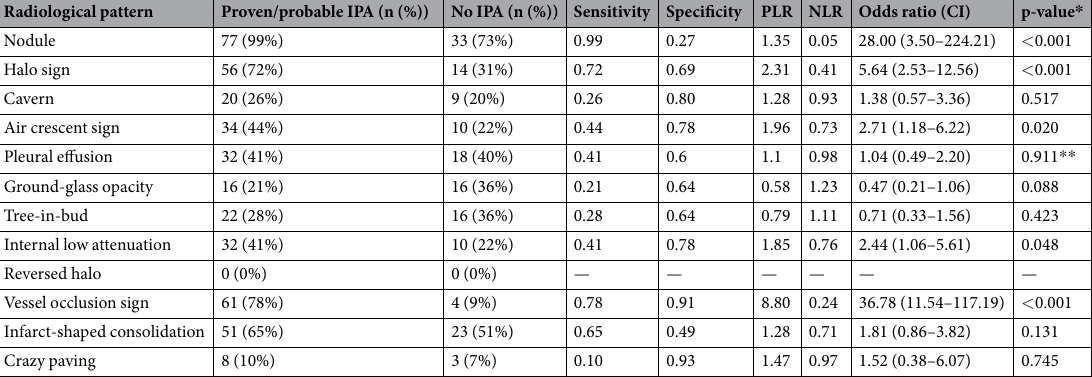
Table 2. Diagnostic performance of different radiological patterns in IPA and controls. IPA: invasive pulmonary aspergillosis; PLR: positive likelihood ratio; NLR: negative likelihood ratio; CI: confidence interval; * probability value of the exact Fisher test (p-value), ** χ ²-test